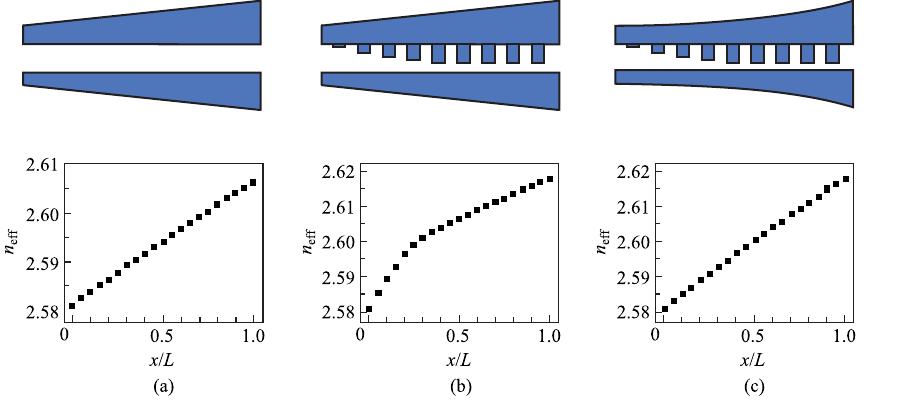
Fig. 2 Simulated mode effective index of the waveguides. a The waveguide width increases linearly from 484 to 504 nm for the upper one and 584–604 nm for the lower one; b the waveguides have linearly increased width with apodized grating, grating apodization follows Eq. (1) and the maximum w